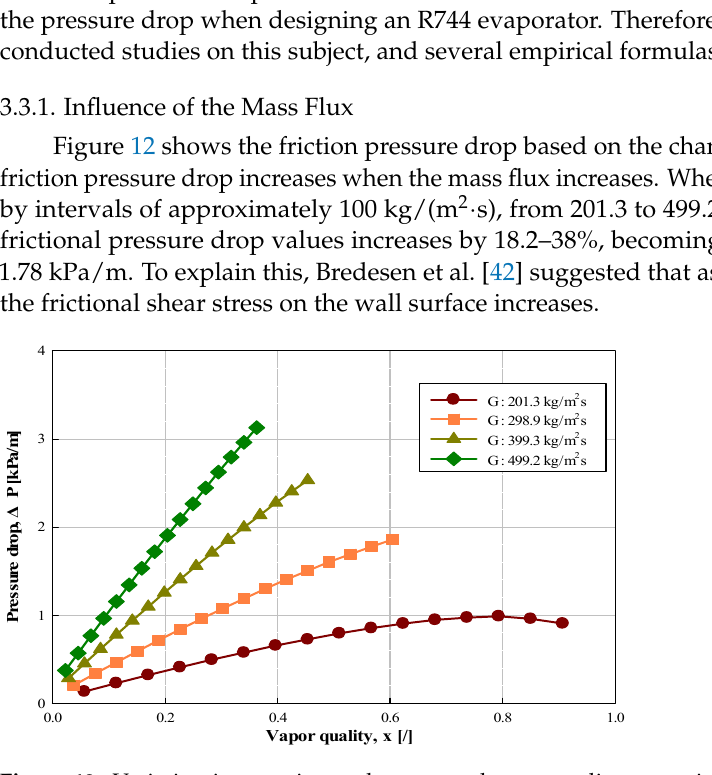
Figure 12. Variation in experimental pressure drop according to various mass fluxes at constant saturation temperature and heat flux ( − 20 °C and 20 kW/m 2 ).